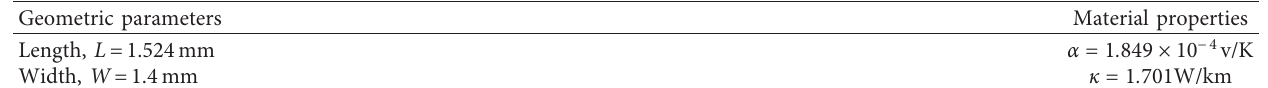
Figure 16: Temperature in case of isothermal inclined crack at t � 100s, along X � 0 or Y � 0. Table 2: Geometric dimensions and material properties